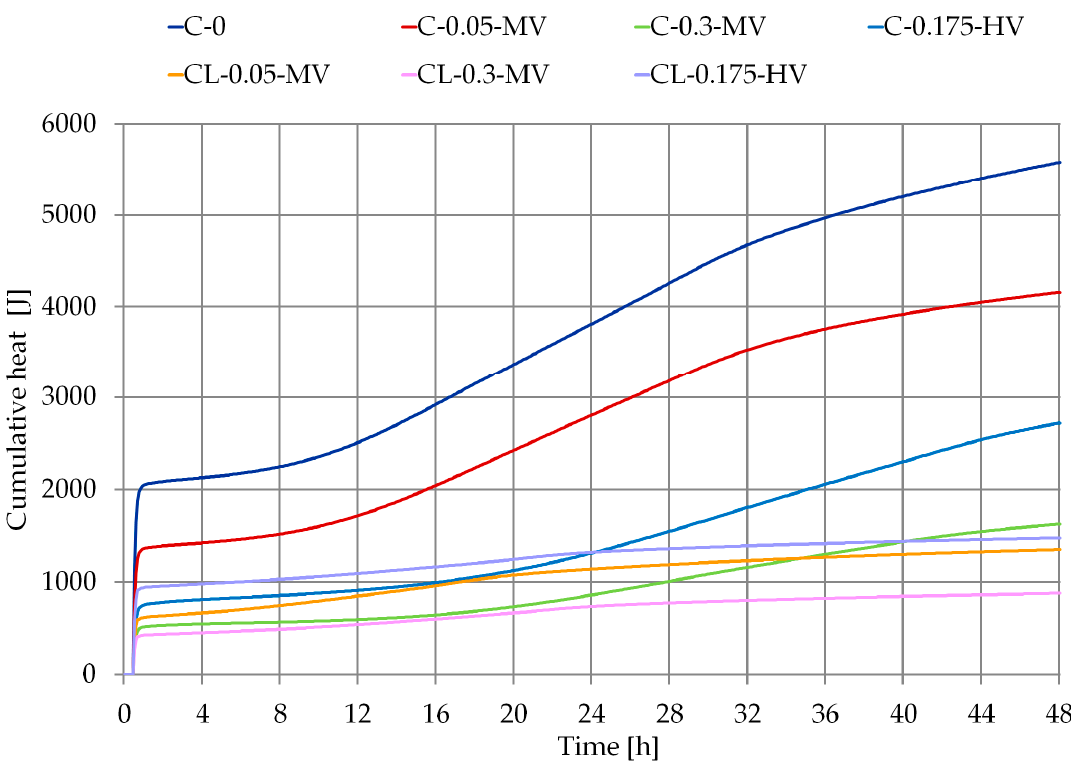
Figure 4. Cumulative curves of all pastes (according to Table 3).